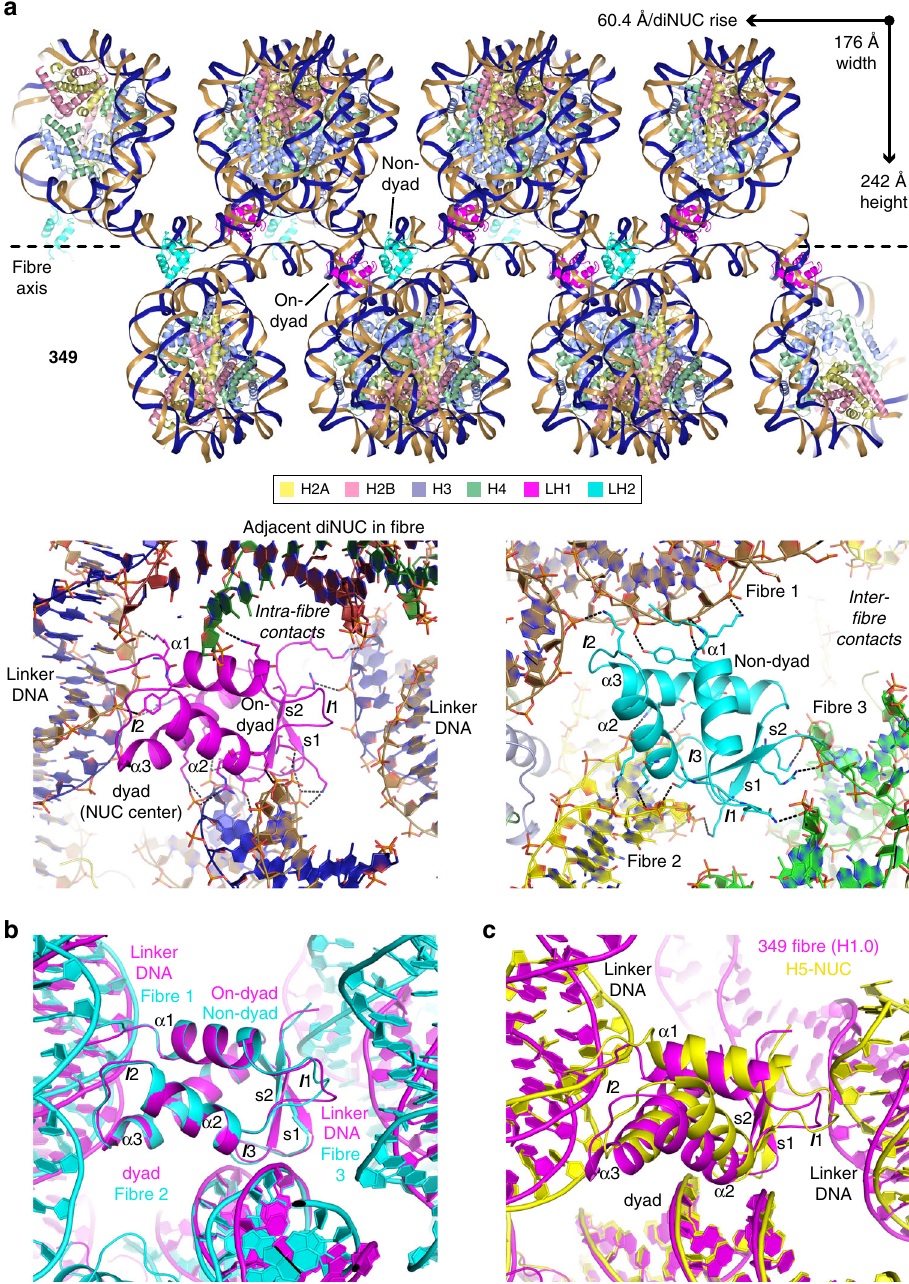
Fig. 6 Linker histone binding to nucleosome fi bres. a A 12-nucleosome section of the 349 fi bre is shown at top, with the DNA coloured as two strands to illustrate the continuity of the double helix. Close views of linker histone association are shown below, with dashed black lines indicating hydrogen bonds. Linker histones are coloured to distinguish the on-dyad (magenta; LH1) and non-dyad (cyan; LH2) binding modes. b Similarities between the on-dyad and non-dyad linker histone binding modes in the 349 structure. The two linker histone structures were least-squares superimposed and are shown together with their corresponding interaction environments in the superimposed frame. c Comparison of the 349 on-dyad linker histone association (magenta) with that of the H5 globular domain bound to a 167 bp nucleosome 31 (yellow). The two linker histone-nucleosome structures were least-squares superimposed. Differential positioning of the linker DNA arms coincides with a corresponding shift in localization of the linker histone globular domain. a , b , c Secondary structural elements of the linker histone globular domain are indicated ( α alpha-helices; s beta-strands; l